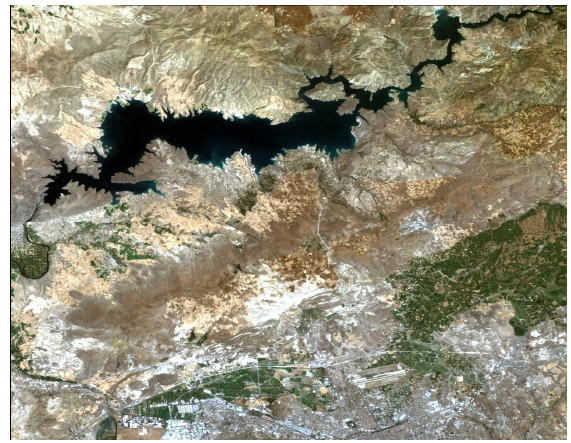
Image 2: Landsat 5 satellite image